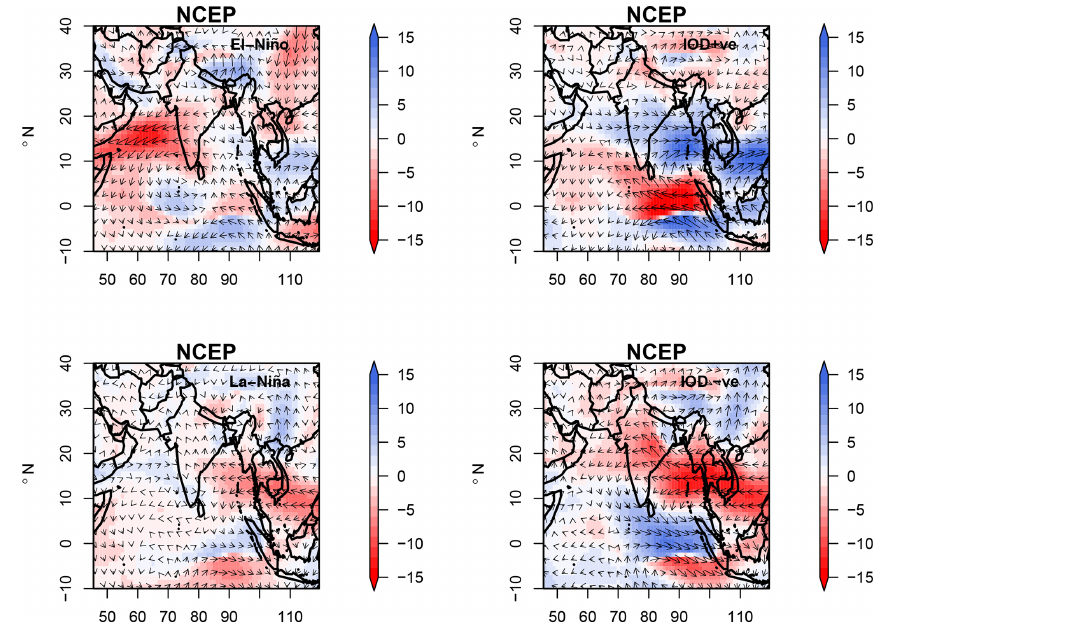
Figure 6. Moisture flux anomalies (gkg − 1 ms − 1 ) over the Indian subcontinent (JJAS) for El Niño, La Niña, IOD + ve, and IOD − ve events observed in NCEP reanalysis datasets for the period of